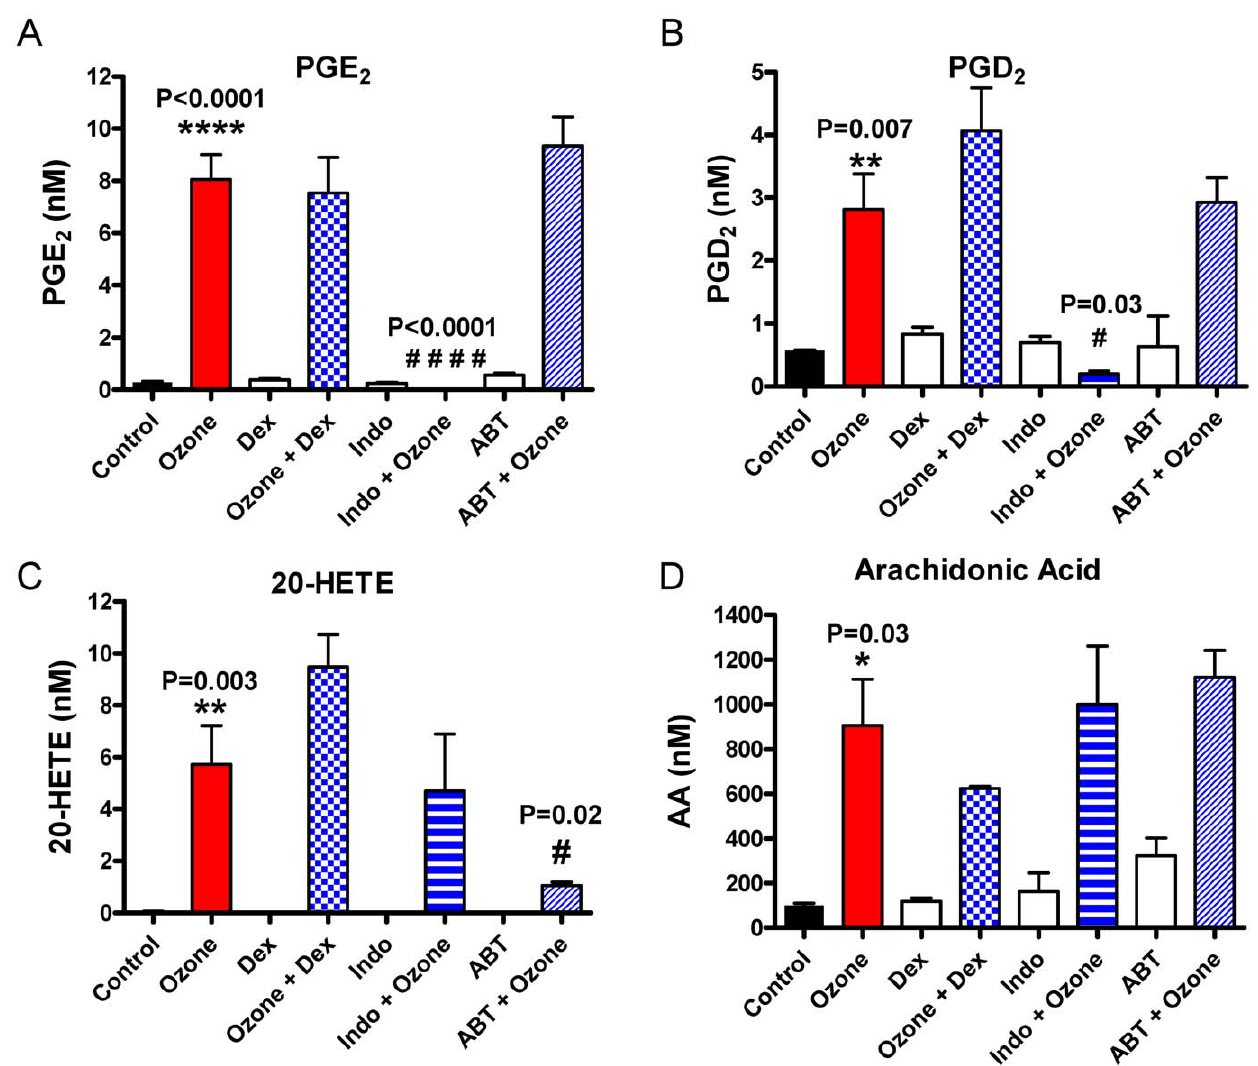
Figure 4. Ozone increases oxidized lipids levels in the BAL fluid. Mice were administered either dexamethasone (2.5 mg/kg) or ABT (50 mg/ kg) 18 h prior or indomethacin (10 mg/kg) 2 hr prior to ozone (6 ppm, 2 h; T=0 h) exposure, with control mice exposed to filtered air. BAL fluid was retrieved and analyzed for (A) PGE 2 , (B) PGD 2 , (C) 20-HETE and (D) AA as previously described. Data is expressed as mean 6 SEM shown. **** P , 0.001 vs. control; ** P # 0.01 vs. control; # P # 0.05 vs. ozone. At least 3 animals were used in each group, and never more than